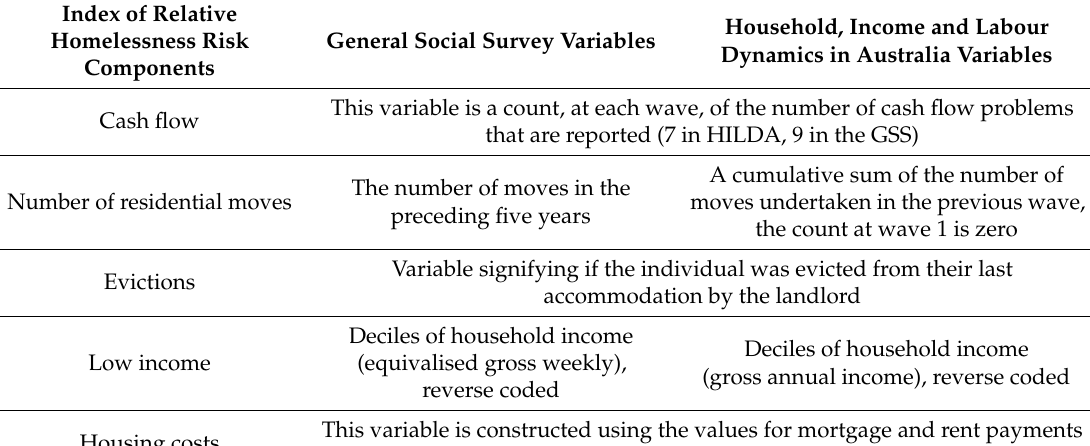
Table 1. Index of relative homelessness risk components by